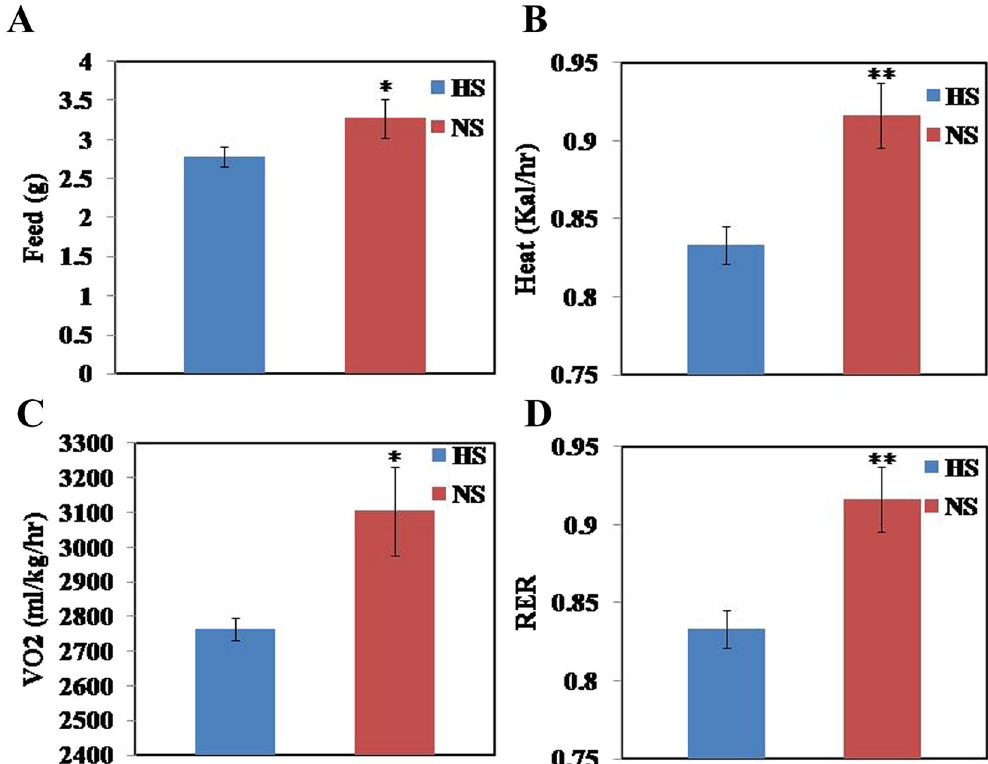
Figure 2. Changes in feed intake and body metabolism. Feed intake and body metabolism were measured after mice were fed a HS (4% NaCl) or NS (0.4% NaCl) diet for 8 wk. ( A ) Feed intake (g), ( B ) heat production (kcal/hr), ( C ) VO 2 (oxygen consumption, ml/kg/hr), and ( D ) respiratory exchange rate (RER). Data are means ± SEM, n = 8. * P < 0.05; ** P < 0.01.